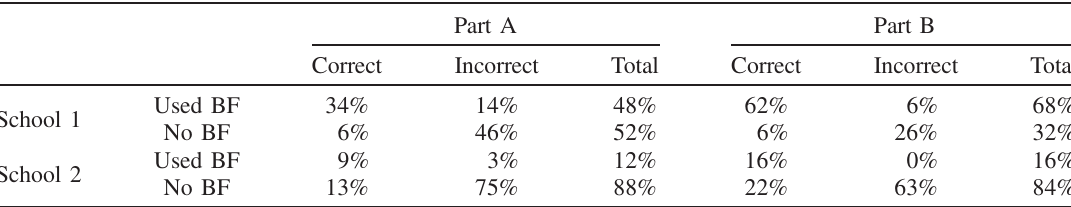
TABLE I. Results from the PRQ pretest at both school 1 ( N ¼ 50 ) and school 2 ( N ¼ 32 ). Students are grouped by whether or not they gave the correct answer ( “ equal to ” ) and whether or not they used the Boltzmann factor (BF) (or stated that the energy of the ground state was irrelevant in part